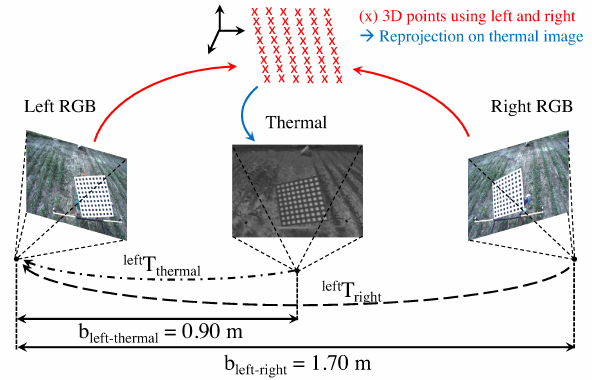
Figure 13. Stereo RGB-Thermal camera